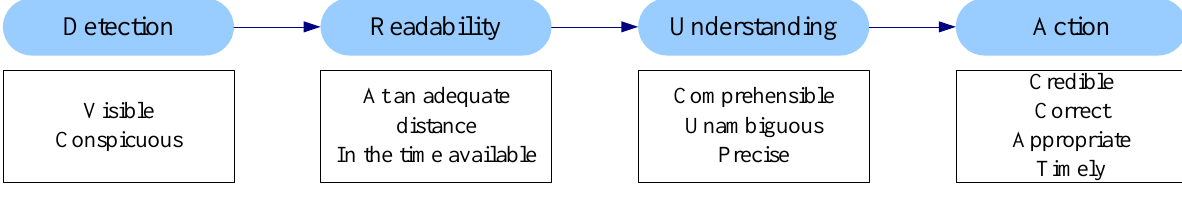
Figure 1. Four stages of traffic sign processing and their requirements (Castro & Horberry,